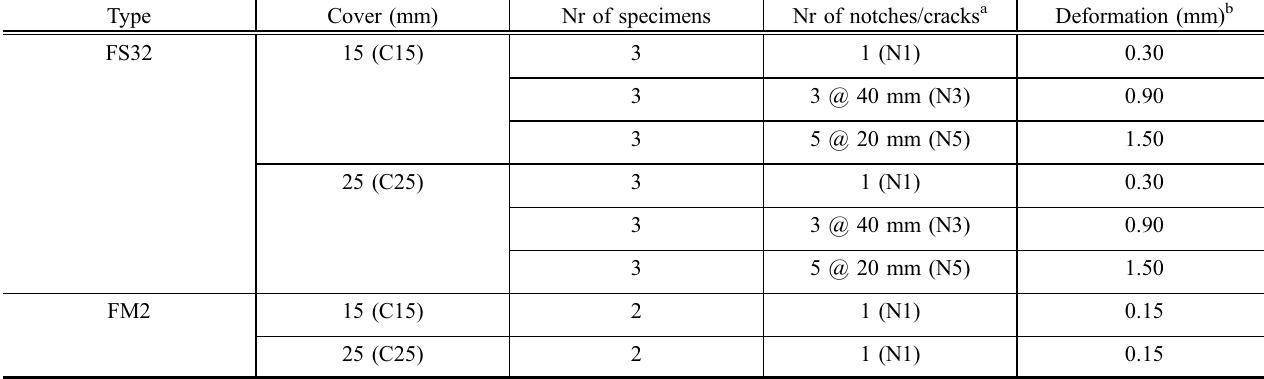
Fig. 1 a FS2, CS2, FM1 and CM1 specimens’ preparation for corrosion testing; b FS31, FS32 and FM2 specimens for corrosion test in chloride exposure by means of ponding; c FS31, FS32 and FM2 specimens under sustained load and d corrosion rate measuring technique using a Coulostatic technique. Table 2 Number of specimens, number of cracks and crack widths in FS32 and